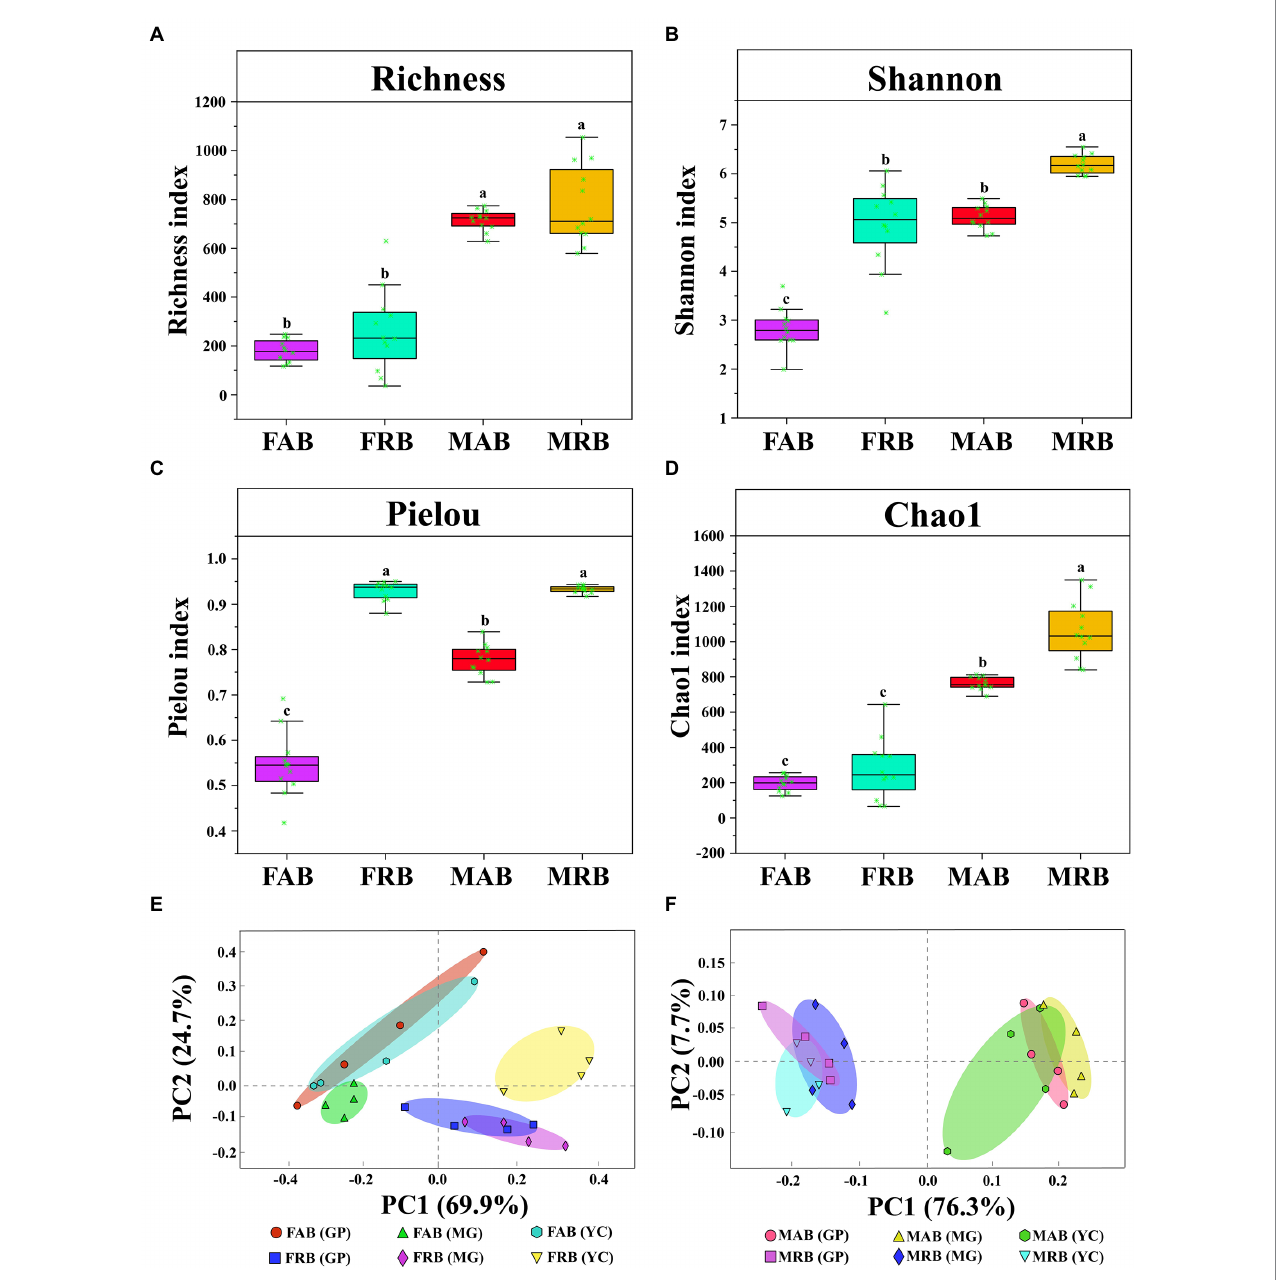
FIGURE 4 Alpha diversity and principal component analysis. (A) The Richness index of abundant and rare bacteria in the fruiting body and mycosphere. (B) The Shannon index of abundant and rare bacteria in the fruiting body and mycosphere. (C) The Pielou index of abundant and rare bacteria in the fruiting body and mycosphere. (D) The Chao1 index of abundant and rare bacteria in the fruiting body and mycosphere. (E) The principal component analysis of abundant and rare bacteria in the fruiting body. (F) The principal component analysis of abundant and rare bacteria in the mycosphere. Note: In Figures (A-D), there is no significant difference in Tukey’s test for the same letter on the boxplot ( p > 0.05). Tukey’s test showed significant differences in patterns with different letters ( p < 0.05). FAB, abundant bacteria of the fruiting body; FRB, rare bacteria of the fruiting body; MAB, abundant bacteria of the mycosphere; MRB, rare bacteria of the mycosphere; GP, Gaopo Township; MG, Mengguan Township; YC, Yangchang